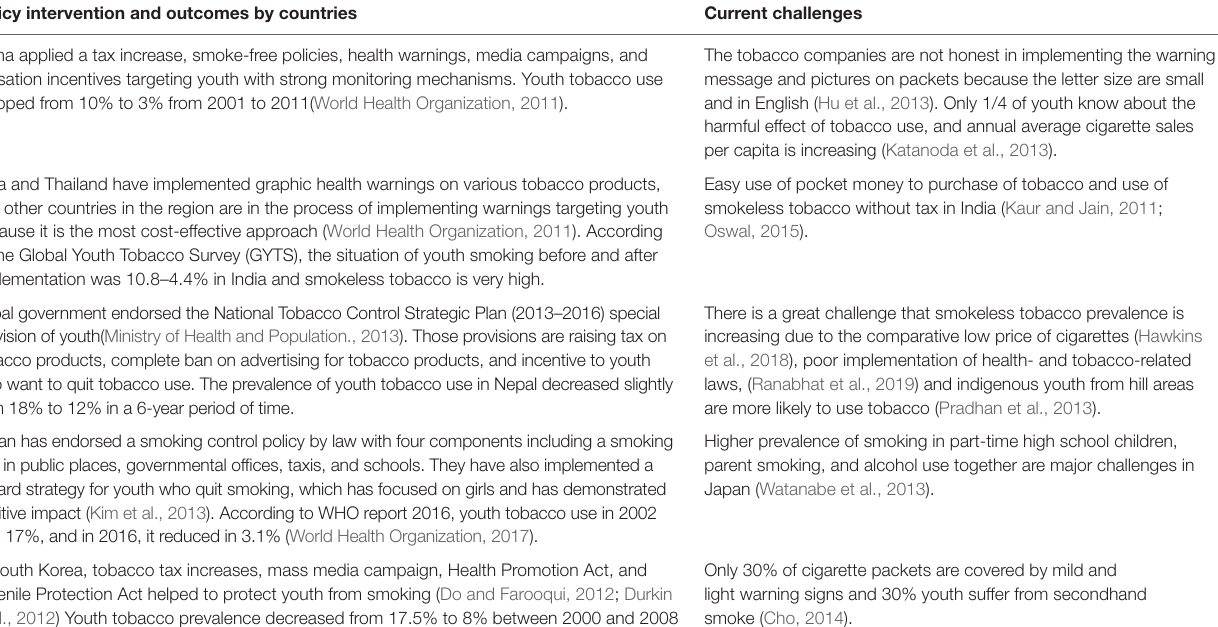
TABLE 2 | National tobacco policies and challenges to